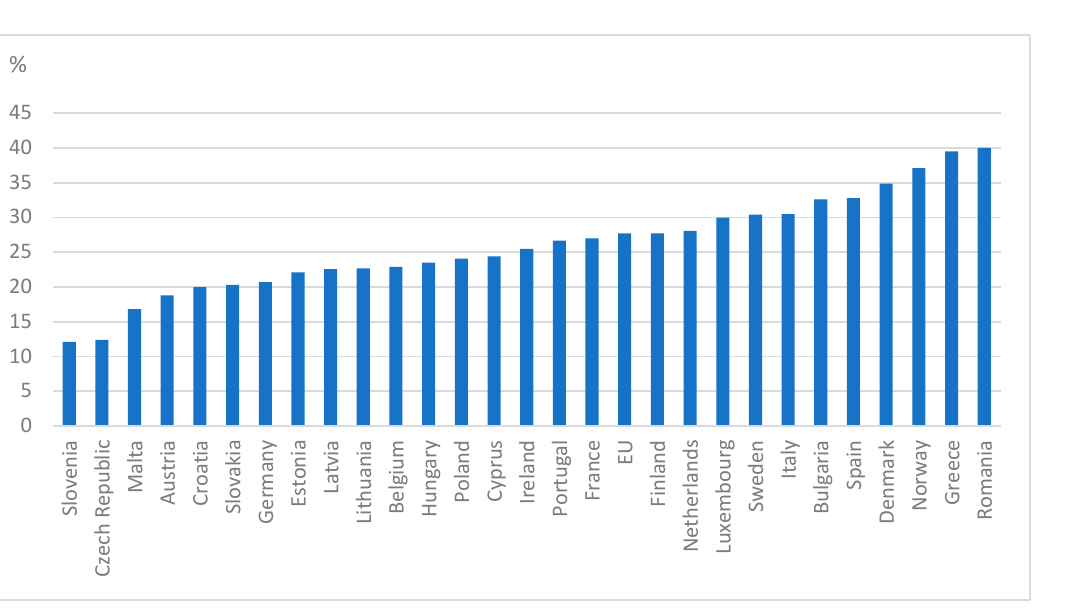
Figure 3. People at risk of poverty or social exclusion, aged 16–24, 2019. Source: Eurostat (2021).